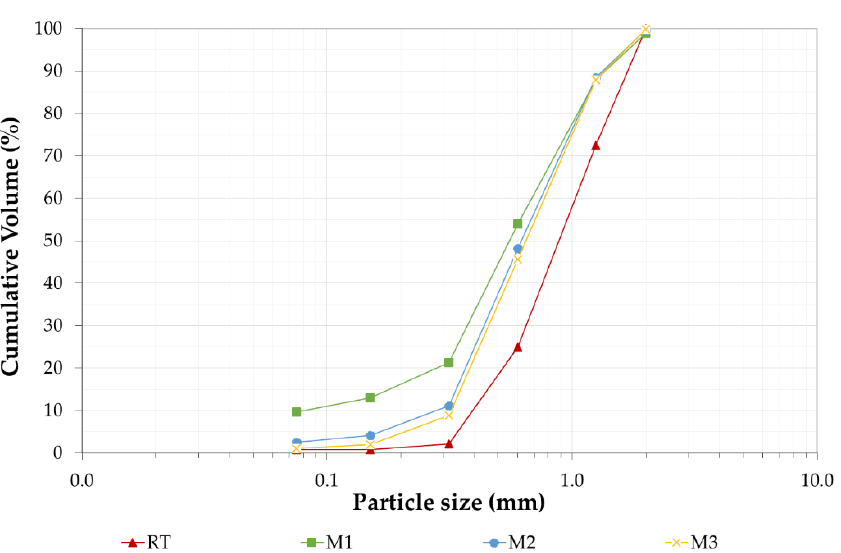
Figure 3. Grain size distributions of the used sands.